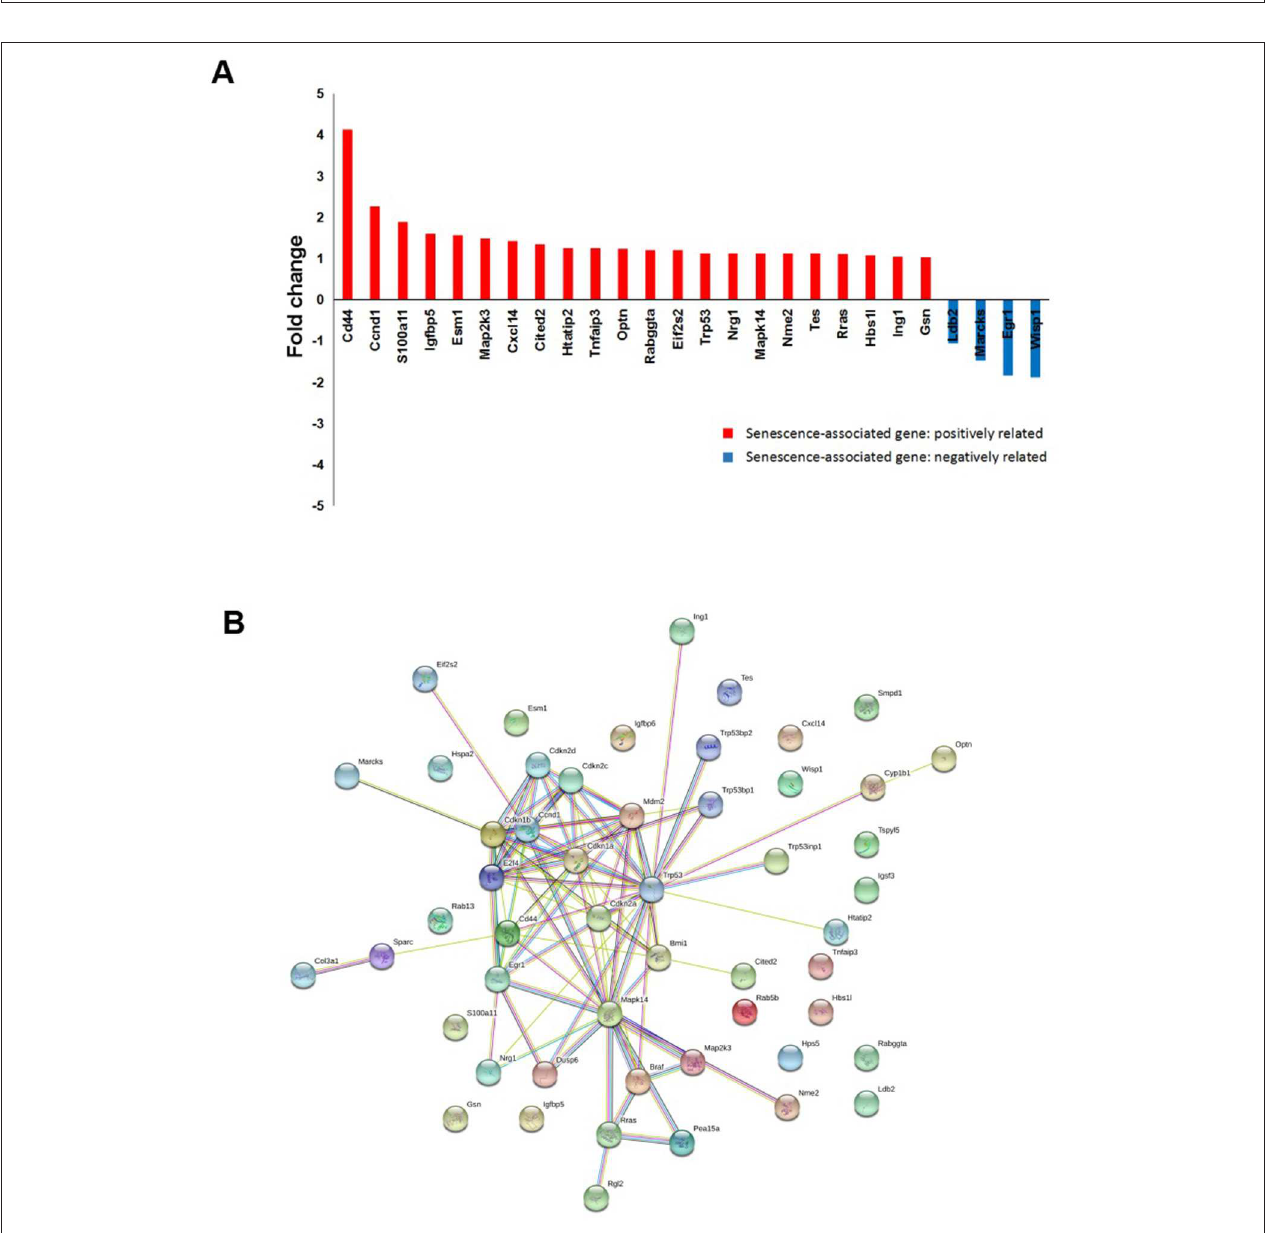
FIGURE 6 | microarray analysis on tumor tissue samples for senescent signature. (A) cDNA-array analysis in the tumor tissues from RAD001 treated mice and control mice showed a slight induction of senescence associated genes ( p < 0.05: RAD001 treated group vs. control group). (B) Senescent related genes differentially expressed between control group and RAD001 treated group ( p < 0.05) were selected for STRING analysis. Protein-protein interaction was